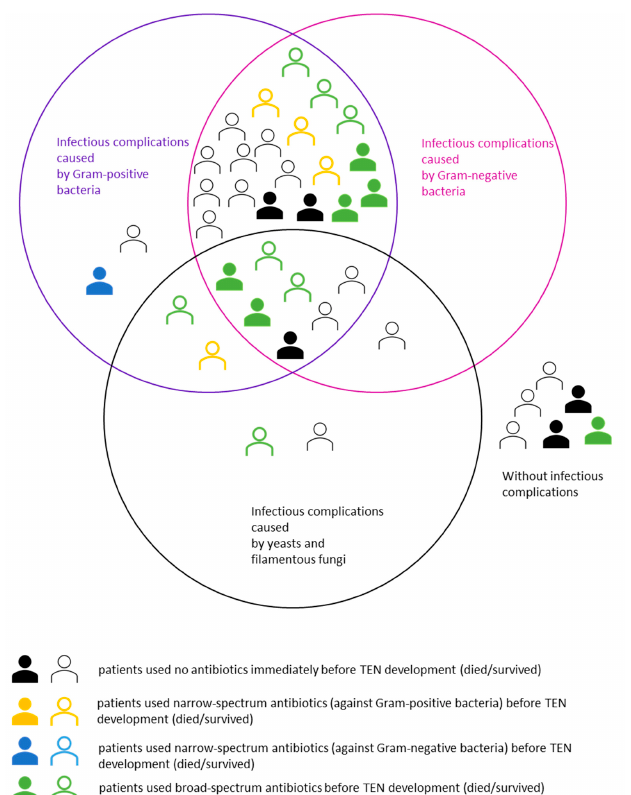
Figure 1. Clustering of 39 patients in the Central European Lyell syndrome: therapeutic evaluation (CELESTE) cohort according to the antibiotics used immediately before TEN development, subsequent infectious complications and their combinations, and patient survival. Microorganisms 2021 , 9 , x FOR PEER REVIEW